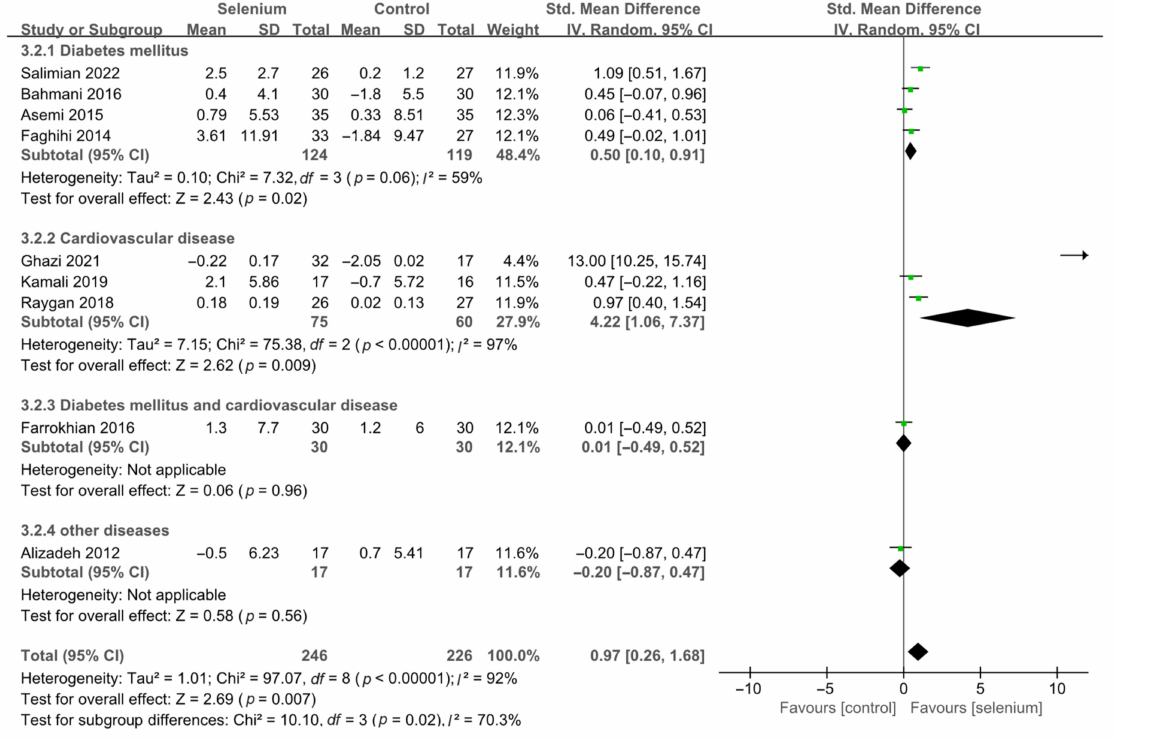
Figure 13. Subgroup analysis of HDL-C [30,41,42,44–49].